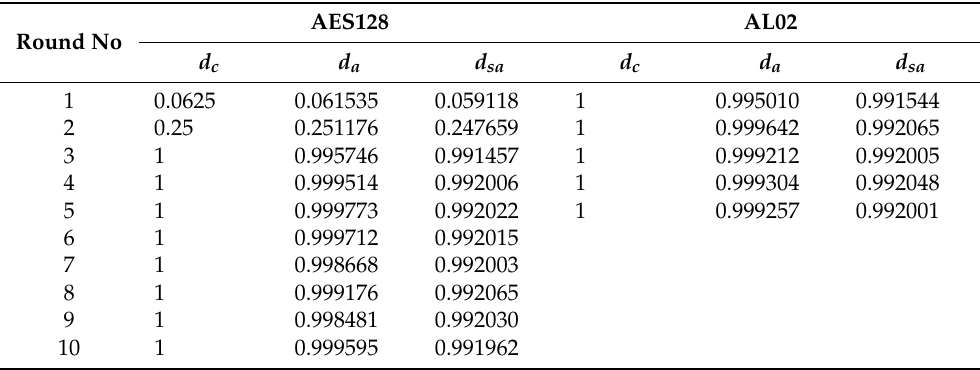
Table 9. Single-round values of indicators of statistical security of the ciphers AES128 and AL02.